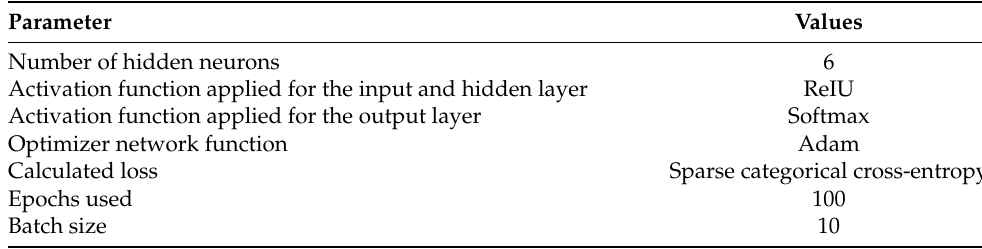
Table A5. Parameters of the artificial neural networks. Parameter Values Number of hidden neurons 6 Activation function applied for the input and hidden layer ReIU Activation function applied for the output layer